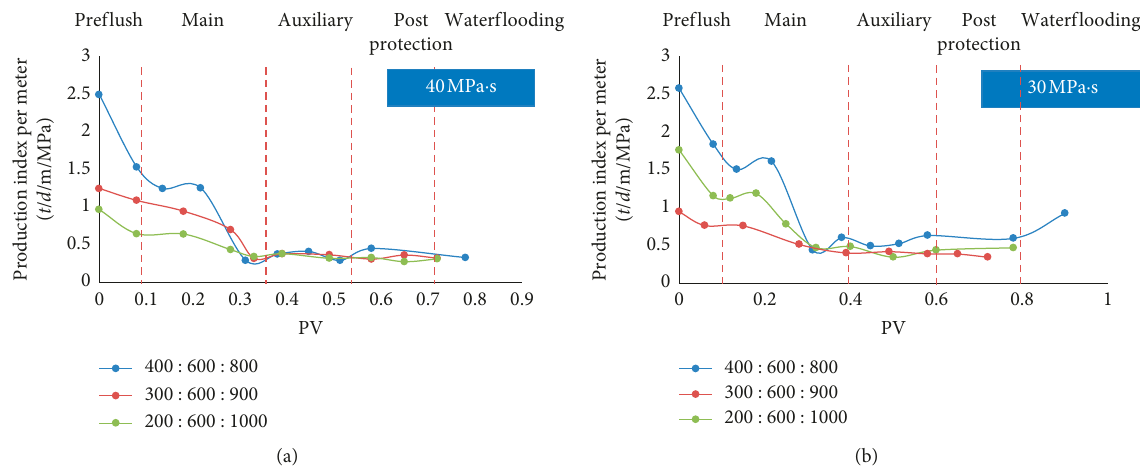
Figure 12: Liquid production index per meter (a) with viscosity of 40MPa · s and (b) with viscosity of 30MPa ·